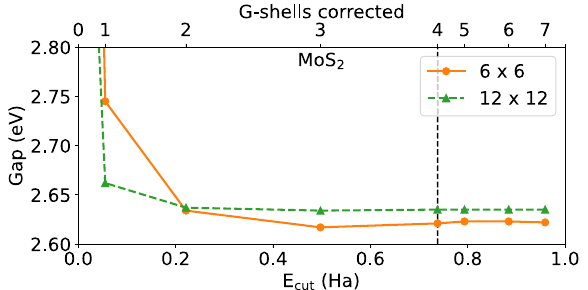
Fig. 5 Convergence of the quasiparticle band gap of MoS 2 obtained with the W-av method with respect to the cutoff energy of the correction. In the upper x -axis it is shown the numbers of G shells corrected. Orange (green) lines indicate results obtained with the 6 × 6 × 1 (12 × 12 × 1) Monkorst – Pack grid. The vertical dashed used in Fig. 4. line indicates the E av cut